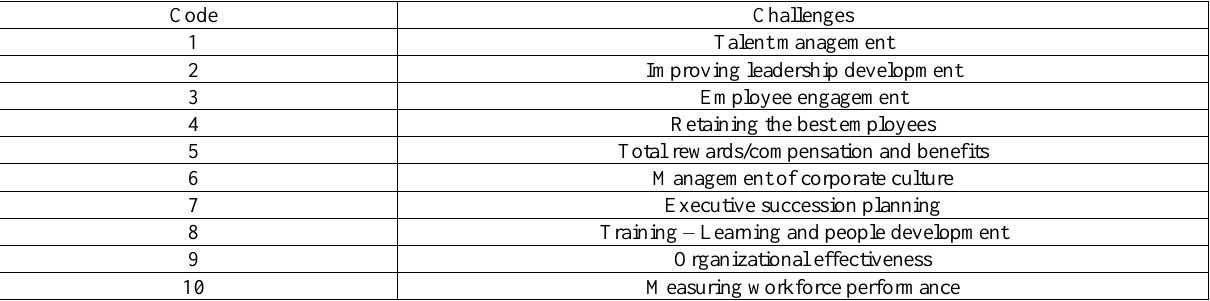
Table 1. The Top Twenty Important Issues in